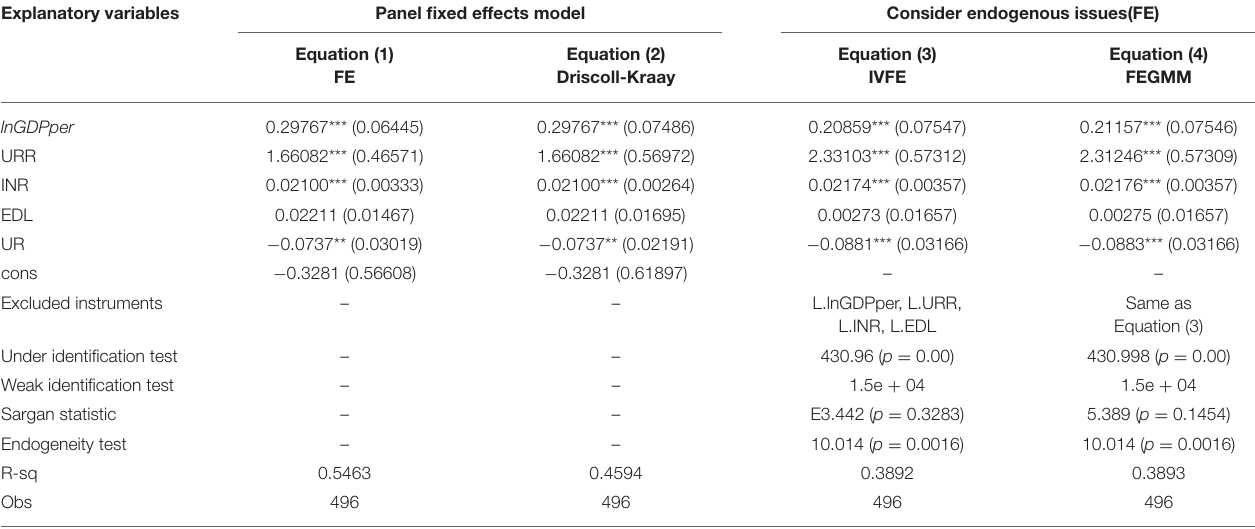
TABLE 2 | Regression